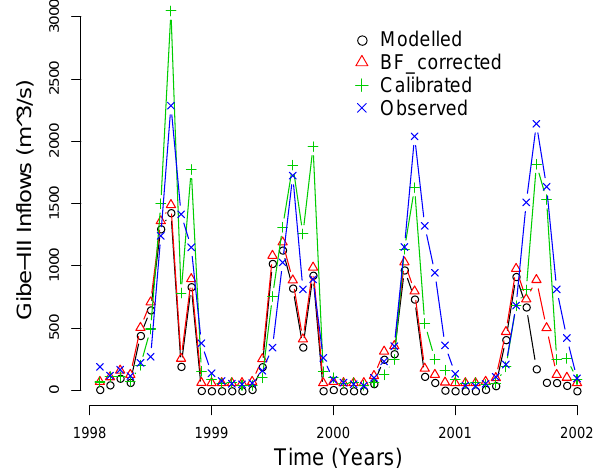
Fig. 2. Validation of calibrated modeled runoff data with observed monthly inflows (1998–2001) at the Gibe III dam site obtained from EEPCo (2009). Model calibrated using mean monthly streamflow data (1964–2001). Also shown are modeled (un-calibrated) and base flow corrected runoff